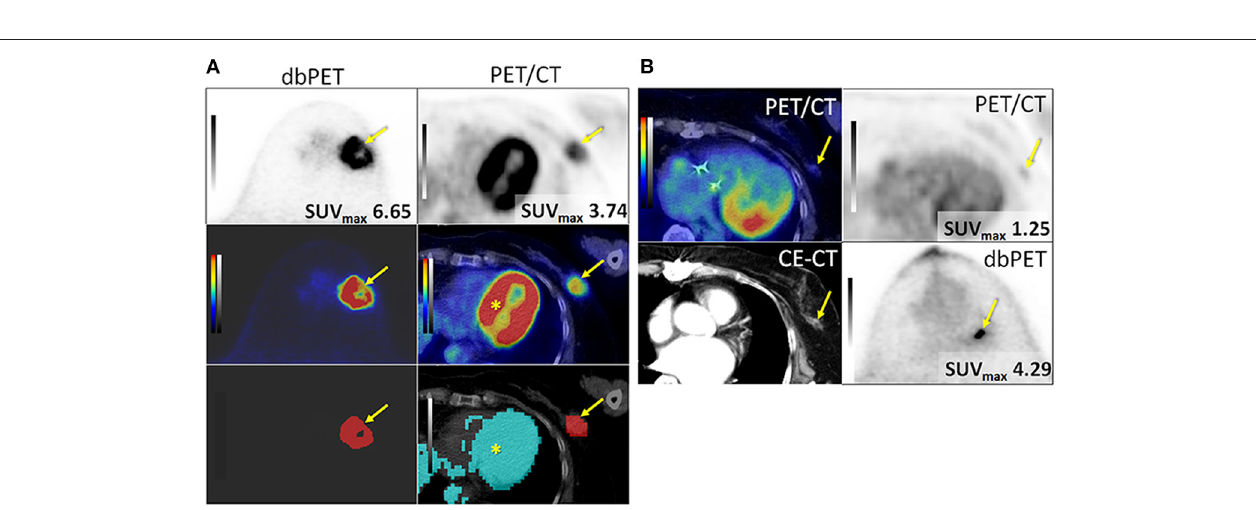
FIGURE 1 | Inclusion and exclusion criteria. FDG, fluorodeoxyglucose; PET, positron emission tomography; dbPET, dedicated breast positron emission tomography; CT, computed tomography.